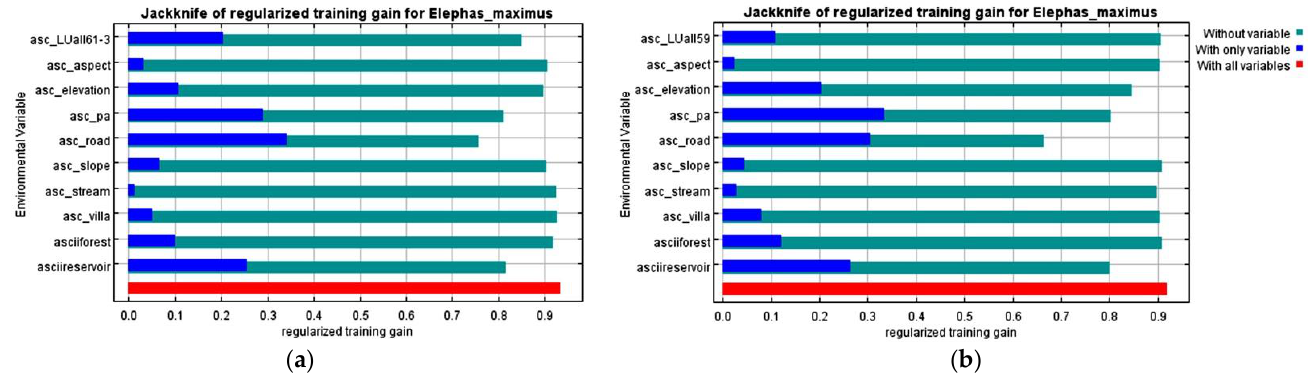
Figure 4. Environmental parameters that related to wild elephant distribution in 2020: ( a ) the dry season and ( b ) the wet season.